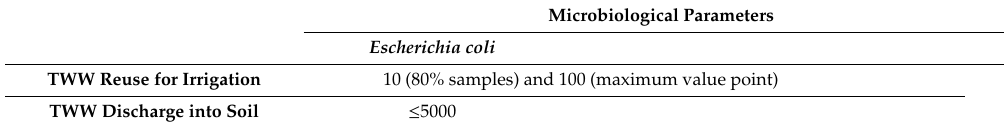
Table 4. Cont. Microbiological Parameters